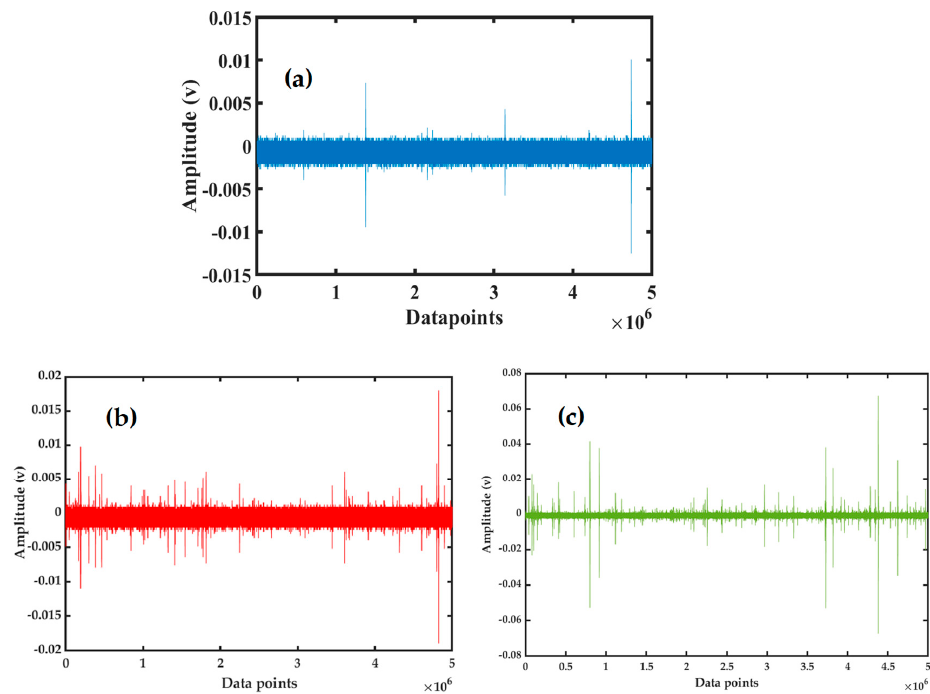
Figure 7. AE signals presenting three different conditions: ( a ) the normal condition, ( b ) micro-cracks, and ( c ) macro-cracks/fractures.